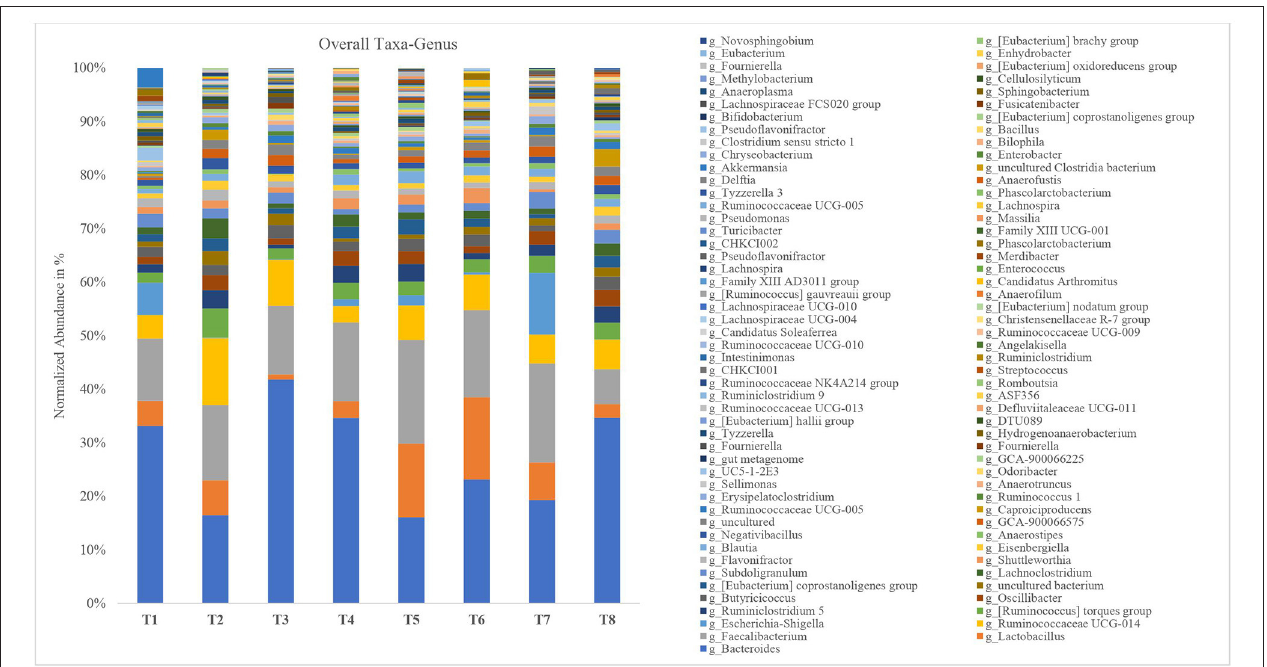
FIGURE 3 | Relative abundance in % of colon microbiota at the genus level. T1 = Negative control (Basal diet), T2 = Positive control [Basalt diet + 0.01% (w/w) Oxytetracycline], T3 = Basal diet + 0.2% (v/w) postbiotic TL1, T4 = Basal diet + 0.2% (v/w) Postbiotic RS5, T5 = Basal diet + 0.2%(v/w) paraprobiotic RG11, T6 = Basal diet + 0.2% (v/w) postbiotic RI11, T7 = Basal diet + 0.2% (v/w) paraprobiotic RG14, T8 = Basal diet + 0.2% (v/w) paraprobiotic RI11. Bacteroides (39.36%) in T3, Faecalibacterium (17.35%) in T5, Lactobacillus (14.39%) in T6, Ruminococcaceae UCG-14 (11.01%) in T2, Escherichia-Shigella (10.33%) in T7 are the most dominant genus.